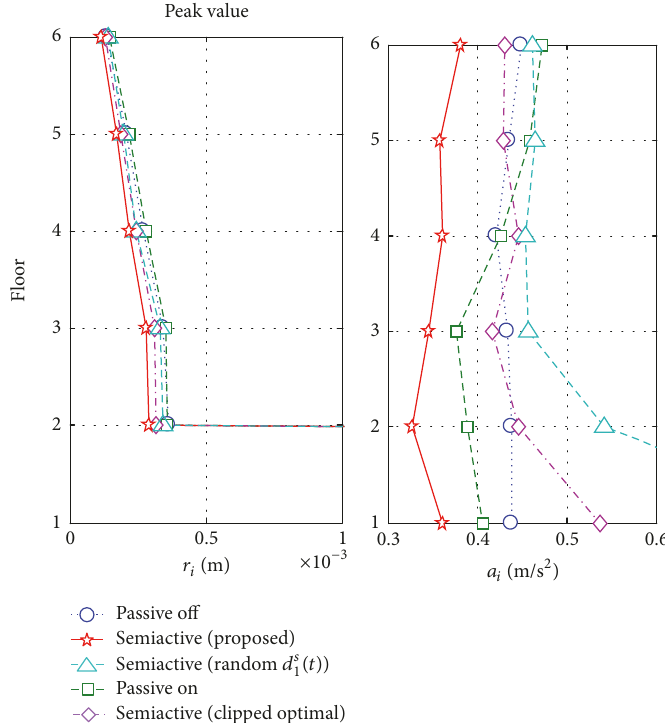
Figure8:SimulationresultsfortheElCentroNS(1940)earthquakedisturbance;peakvaluesoftherelativedisplacementbetweenneighboring floors and absolute acceleration of each floor.